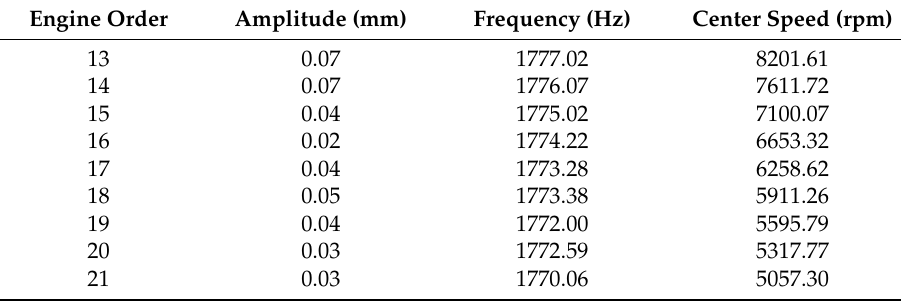
Figure 10. Model fitting result of blade 6# at 8200 rpm, engine order (EO) = 13. Table 2. Model fitting results of blade Table 2. Model fitting results of blade 6#. Table 2. Model fitting results of blade 6#.